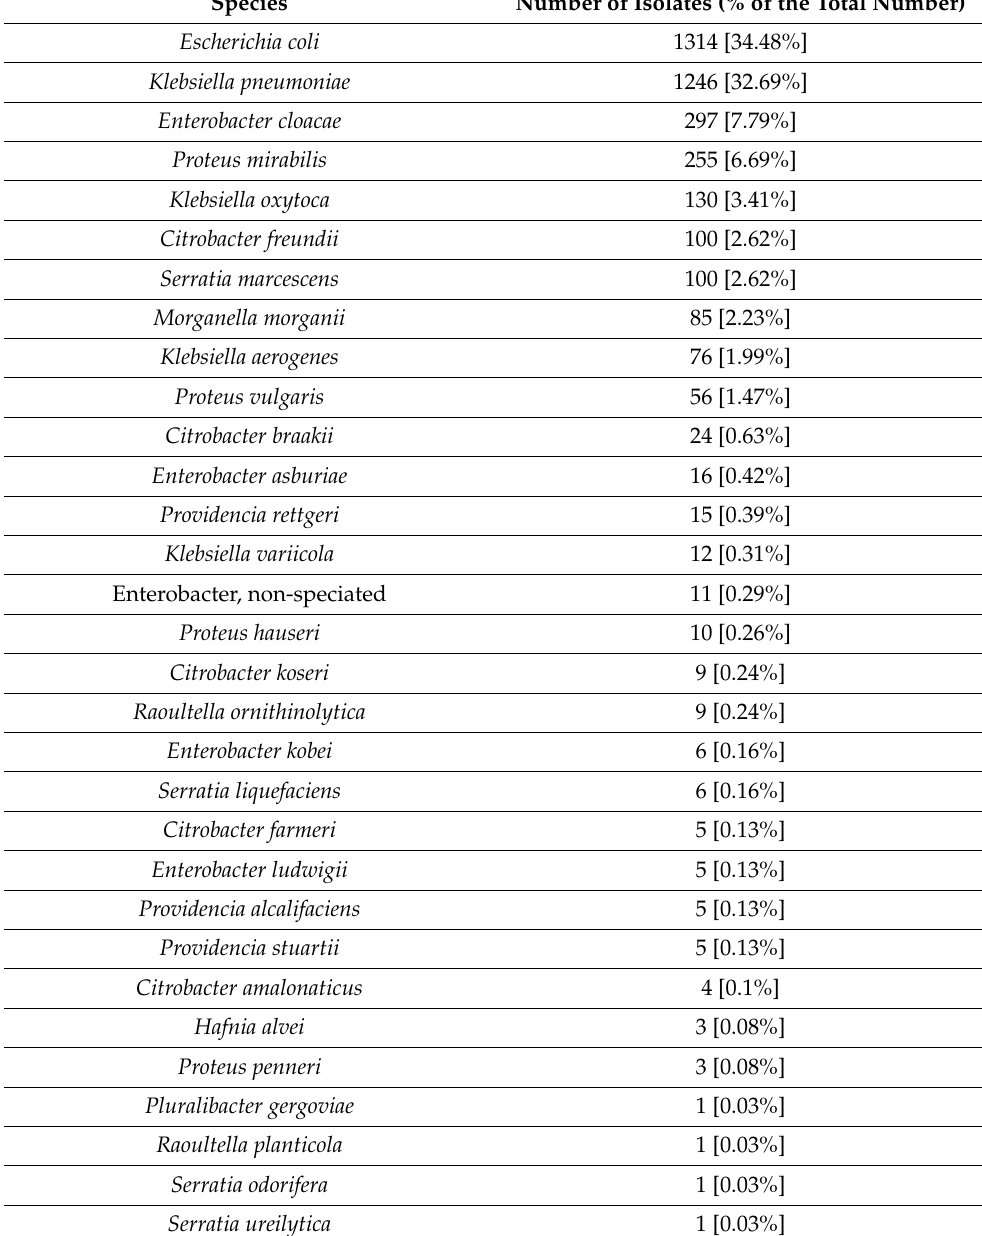
Table 2. The overall distribution of the isolates according to